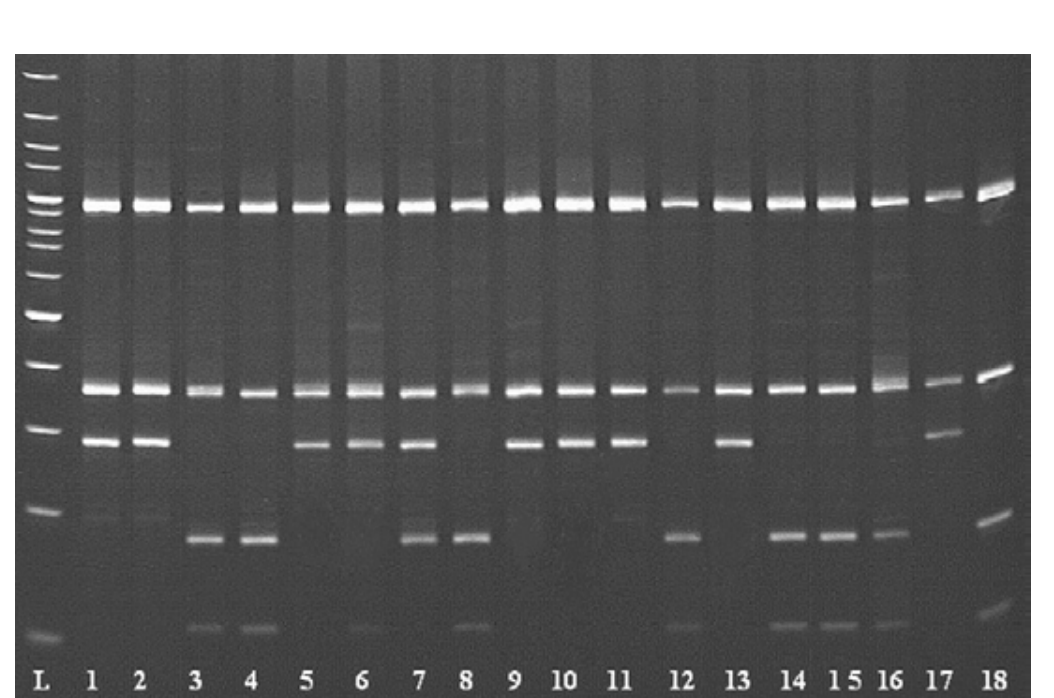
Figure 1. Polyacrylamide gel showing the RFLP patterns of phytoplasma ribosomal DNA fragment amplified with F1/B6 primers digested with Hpa II restriction enzyme of apple samples from the survey of apple trees in Central and Southern Poland during 2010-2013. Lanes: L – molecular marker 100 bp. 1. J8148, 2. J4020, 3. Przel, 4. SzamP, 5. GoC, 6. GoP, 7. Tward, 8. Oz, 9. RBoC, 10. Bor, 11. JoC , 12. Mut, 13. GlP, 14. Kotlar, 15. Kijak, 16. GDel, 17. Głowno, 18. AP-15 reference